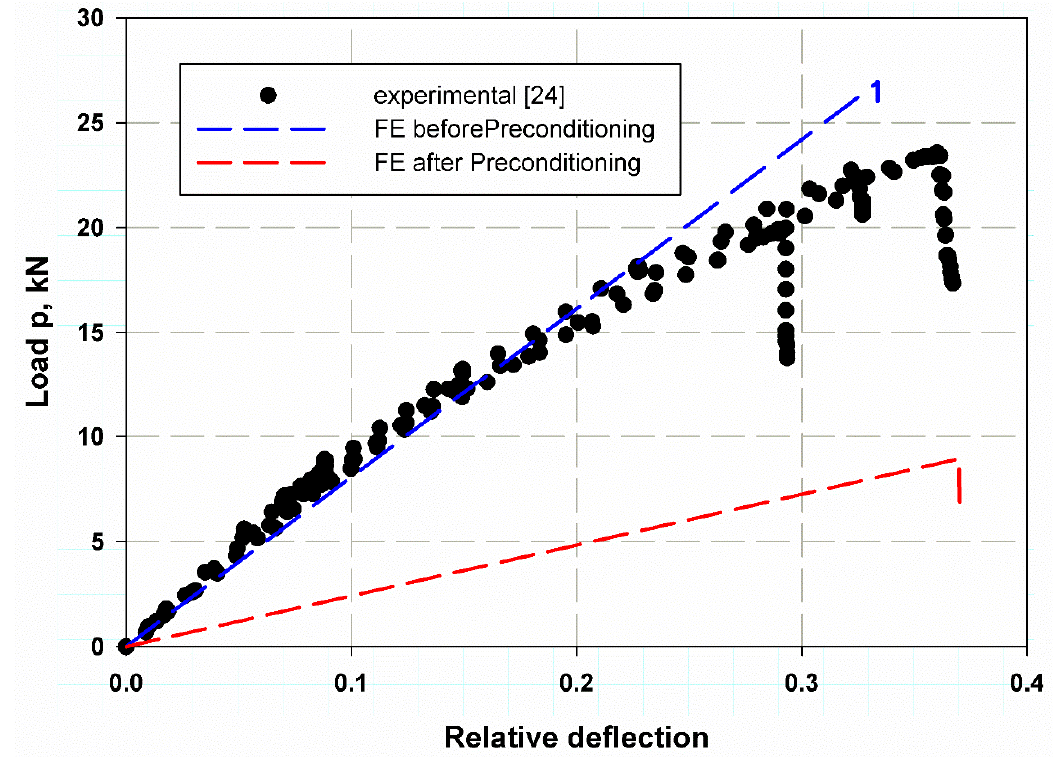
Figure 16. Validation of prediction ring stiffness load with experimental results of Ref. [24].